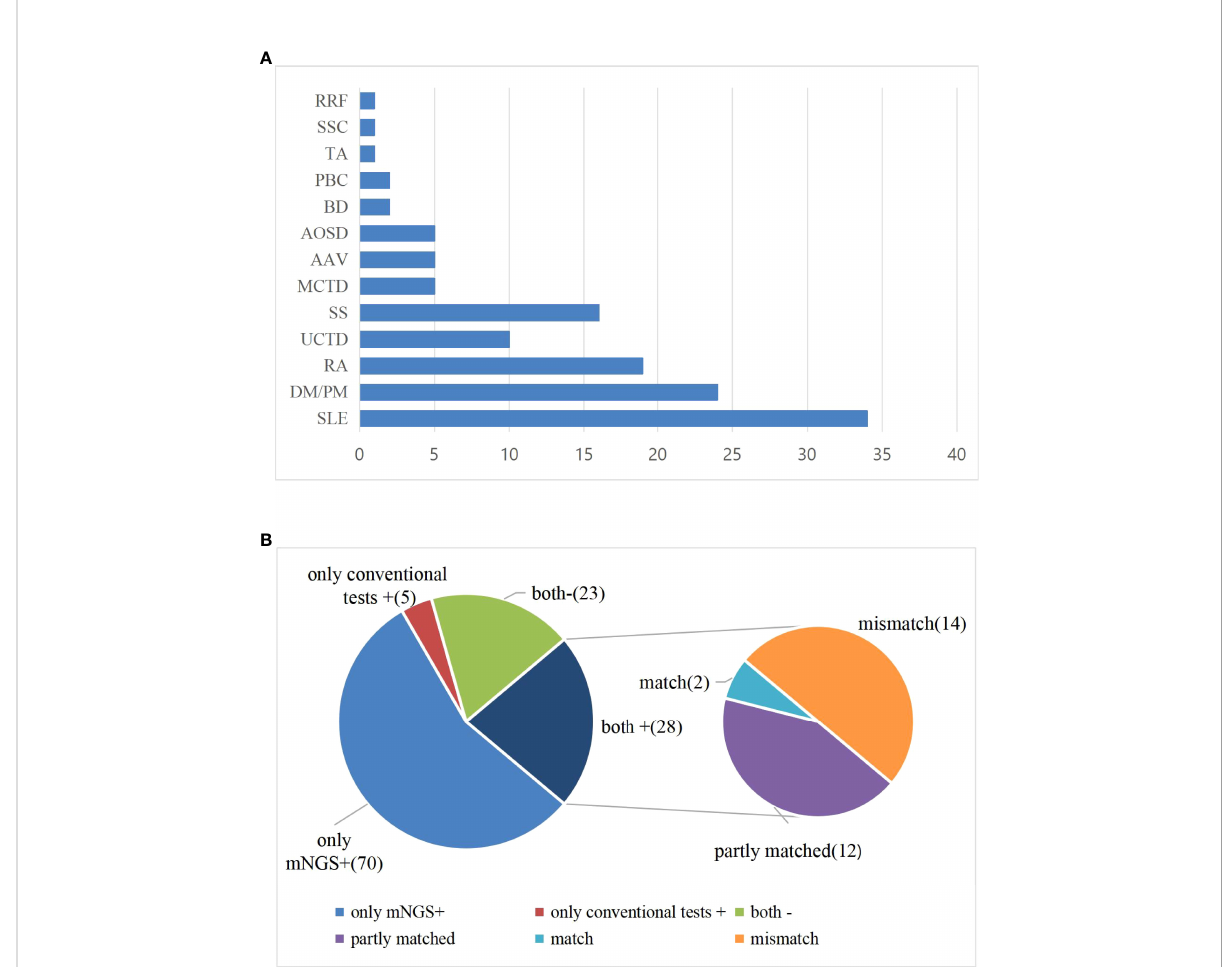
FIGURE 1 (A) Distribution of disease types among all enrolled patients. (B) Comparison of test results between mNGS and conventional diagnostic testing methods (CDT) in peripheral blood of patients with CTD. Both+, results of mNGS and CDT were both positive; both-, results of mNGS and CDT were both negative; only mNGS+, only the mNGS result was positive; only conventional testing+, only the CDT result was positive. Match, results of mNGS were totally identical with those of CDT; partly matched, results of mNGS and CDT were totally matched, mNGS often identi fi ed more pathogens than conventional methods; mismatch, results of mNGS and CDT were totally